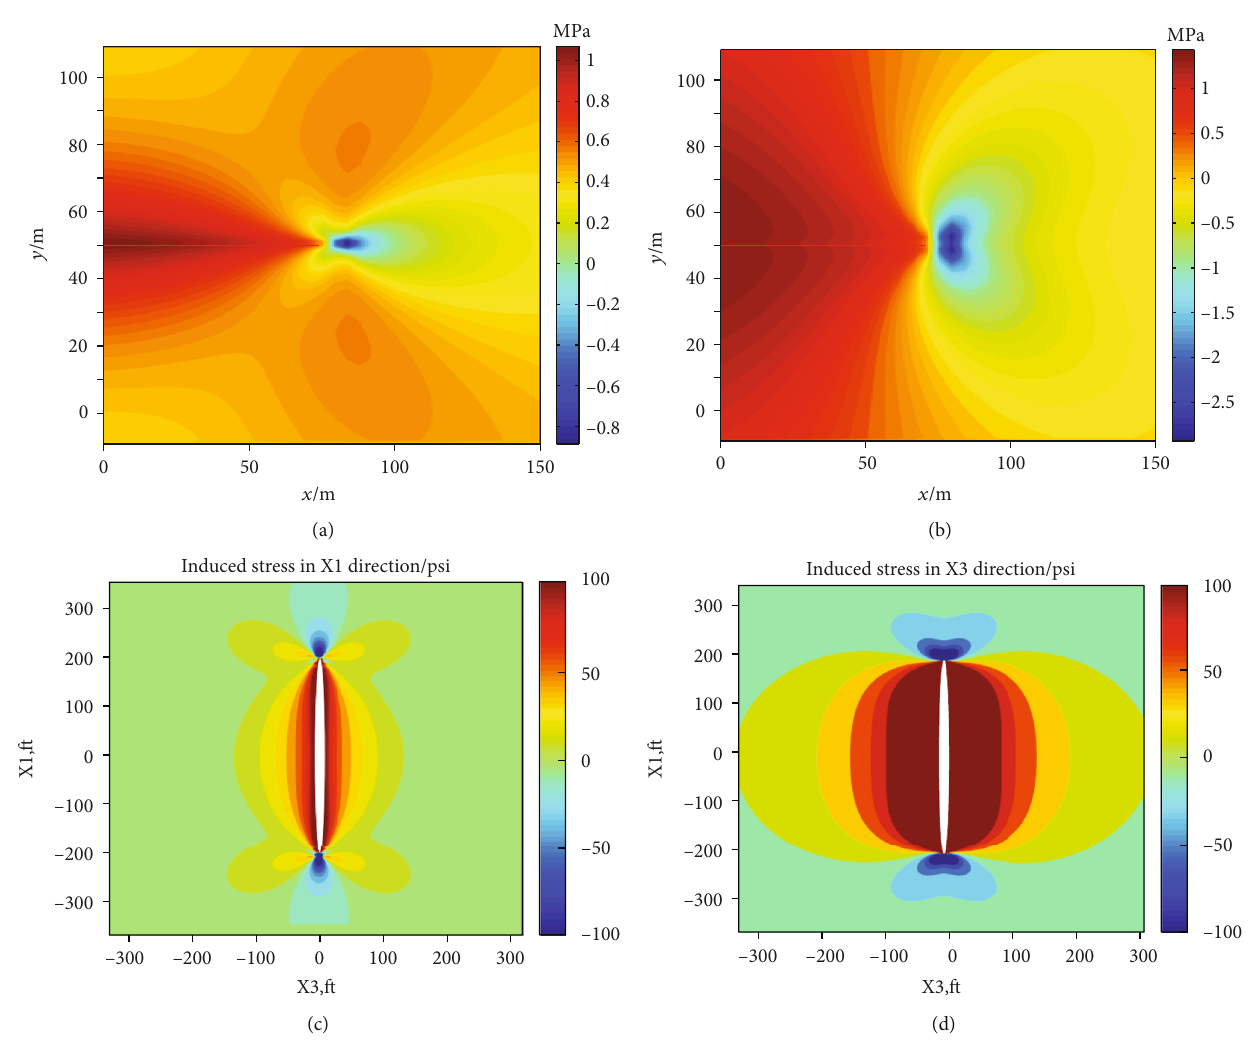
Figure 6: Comparison of dimensionless stress contour between our model and literature [34]: (a, c) direction of maximum principle stress; (b, d) direction of minimum principle